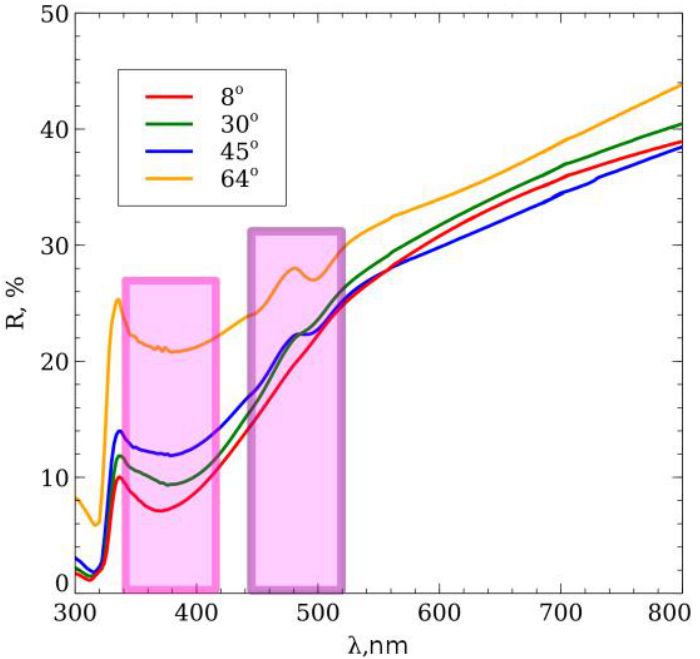
Figure 6. Specular reflectance spectra of the sample Ag-4 collected under different incidence an- gles.